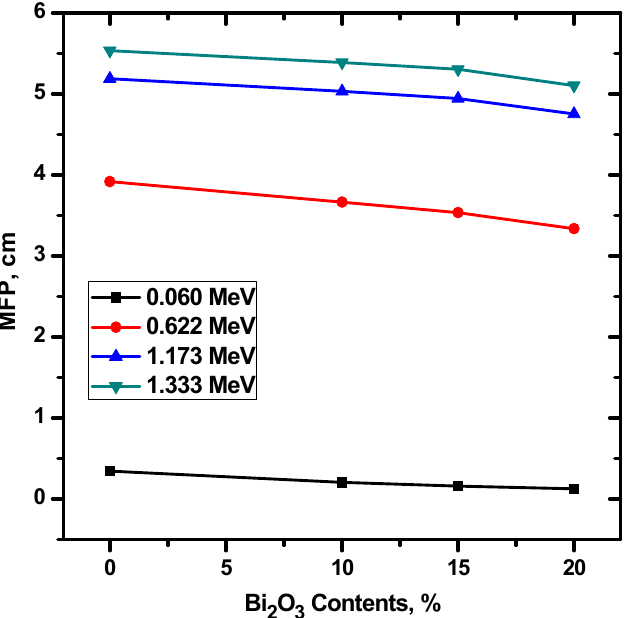
Figure 9. The MFP for the prepared ceramics as a function of Bi 2 O 3 .